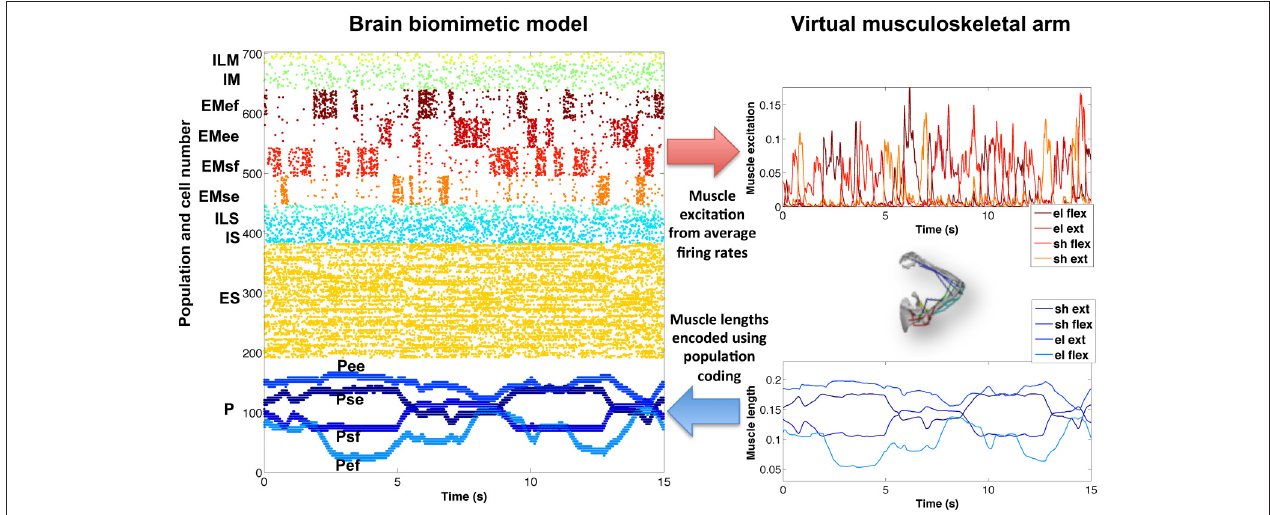
FIGURE 5 | Encoding of virtual arm muscle excitations (top right) and lengths (bottom right) in the biomimetic spiking model firing patterns (raster plot on the left). For comparison purposes, the same colors have been used to represent the spikes corresponding to the excitations (or lengths) of each muscle group. Note that P cells are ordered by muscle length, such that cells belonging to each muscle group subpopulation are spaced (in steps of 4) across the full P population, e.g., P sf = cells 0 , 4 , 8 , ··· , 188 .